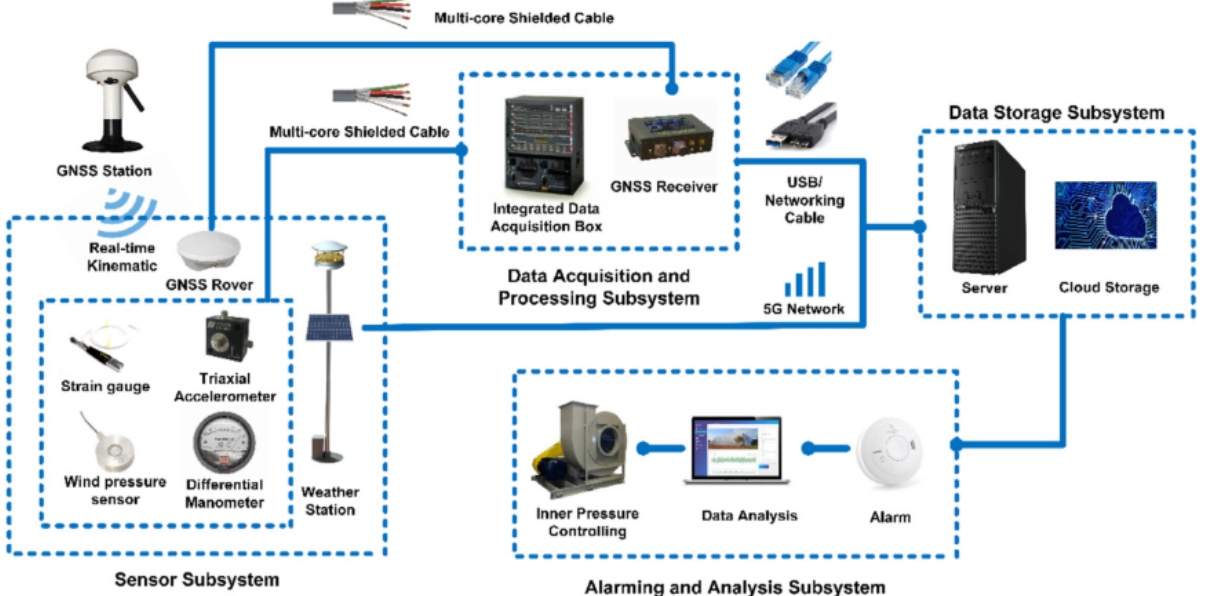
Figure 24. SHM system framework for the air-supported membrane structure of Shanghai Jiao Tong University [19].